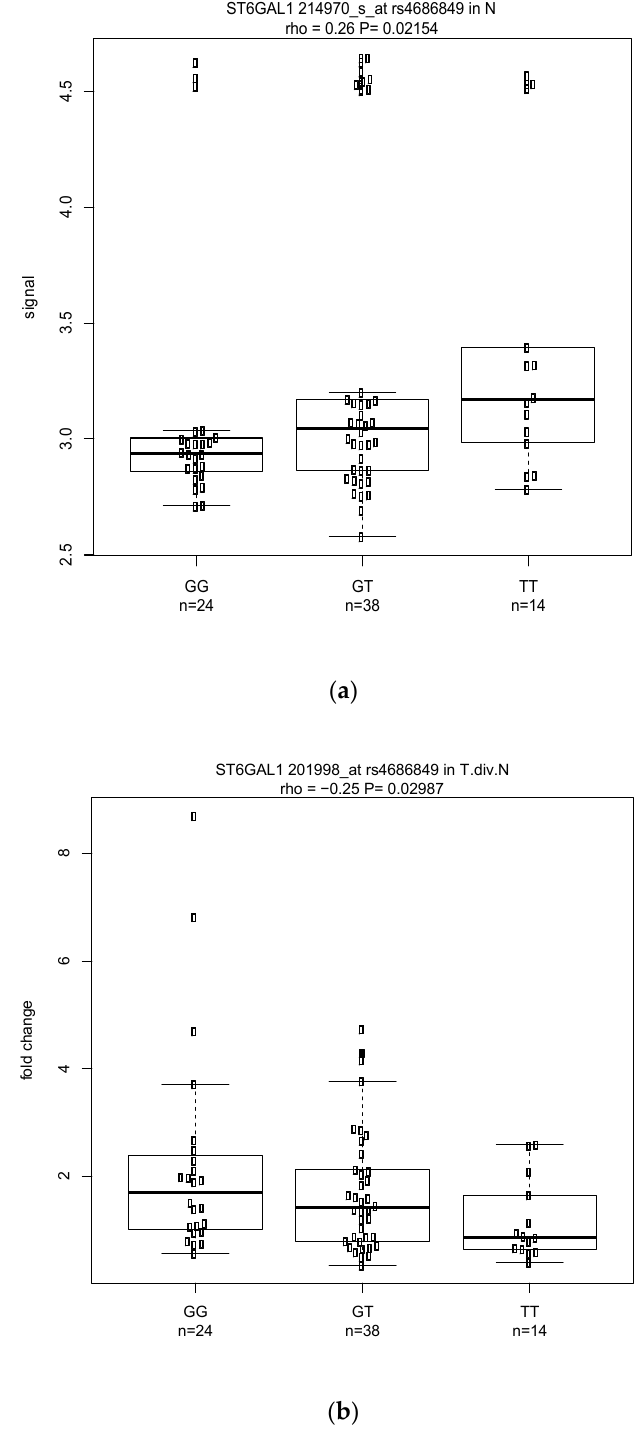
Figure 3. ( a ) Distribution of signal in normal and the correlation with p = 0.02 and a positive rho = 0.26 for the gene–SNP pair ST6GAL1 (214970_s_at) rs4686849. ( b ) Distribution of the tumor vs. normal fold change and the correlation with p = 0.03 and a negative rho = − 0.25 for the same gene–SNP